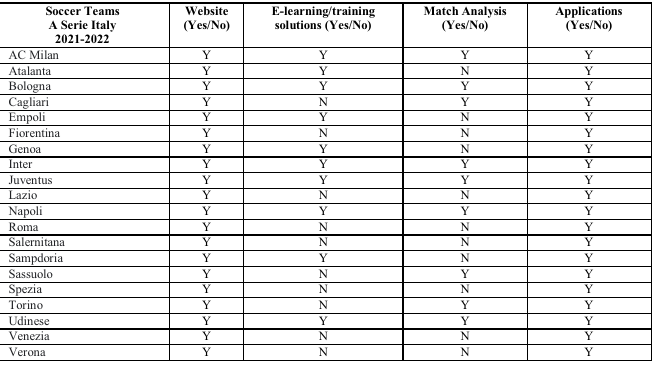
Table 2: A brief portrait of the Italian Serie A Championship in the 2021/2022